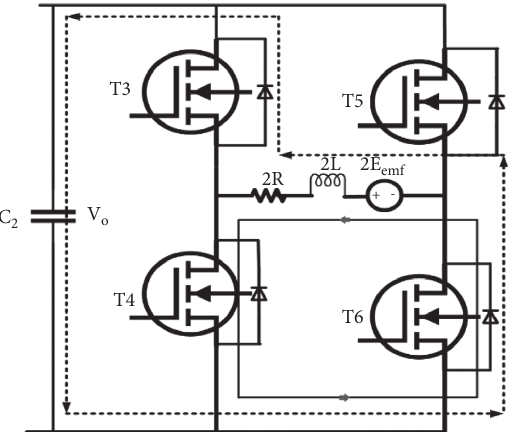
Figure 10: Equivalent circuit of two active phases of VSI during regenerative